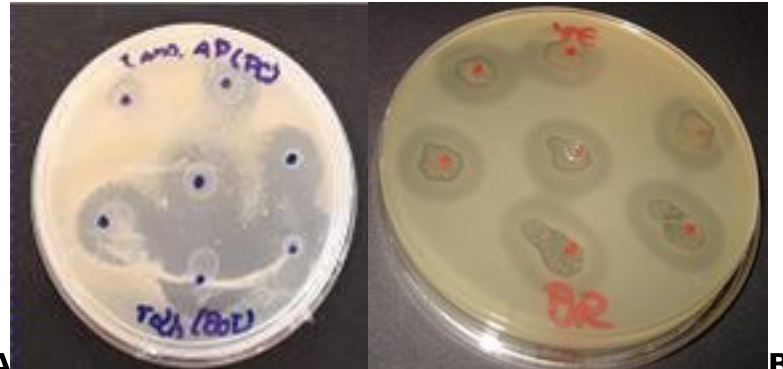
Figure 3. The isolated microorganism from Prunus spp. leaves (white colony) showed inhibition halos against Staphylococcus coagulase-positive strain in peptone agar (A) and yeast extract agar (B).